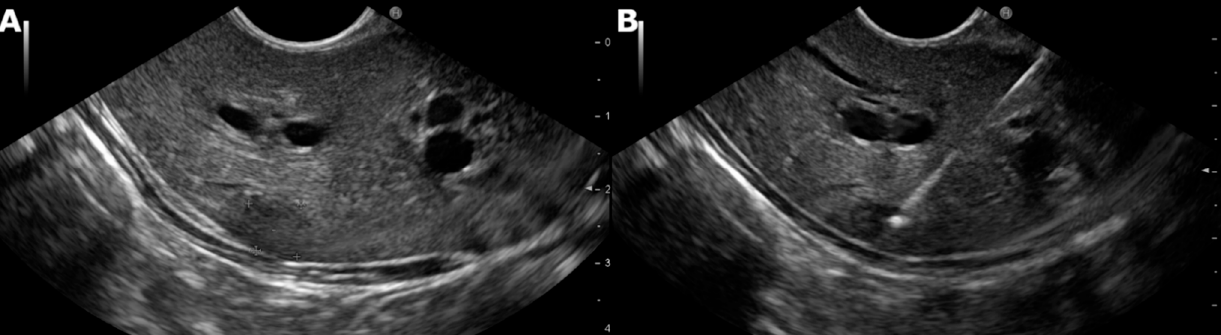
Figure 2. ( A ) Linear echoendoscope showing a focal lesion in the left lobe of the liver in segment II. ( B ) Linear echoendoscope showing fine-needle biopsy of the focal lesion in the left lobe of the liver in segment II.